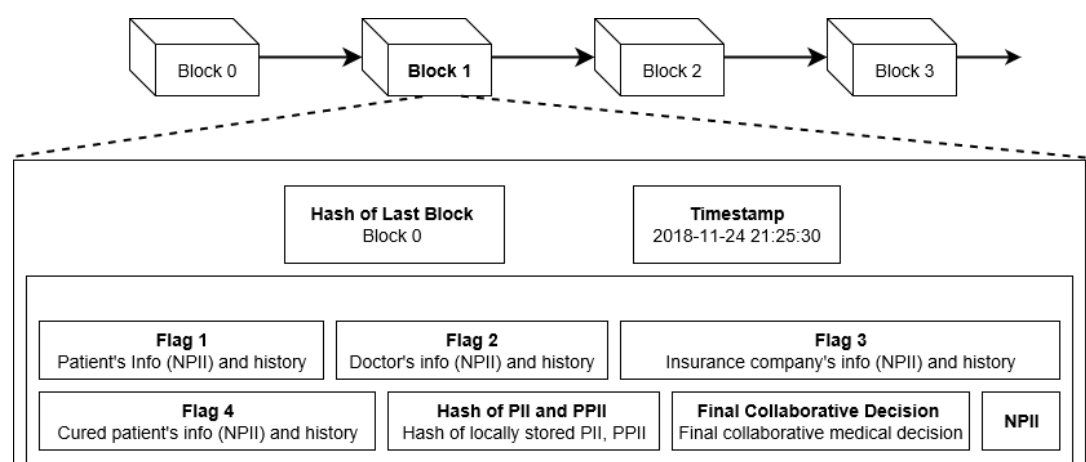
Figure 7. Sample block architecture of the proposed scheme (Block 1). •